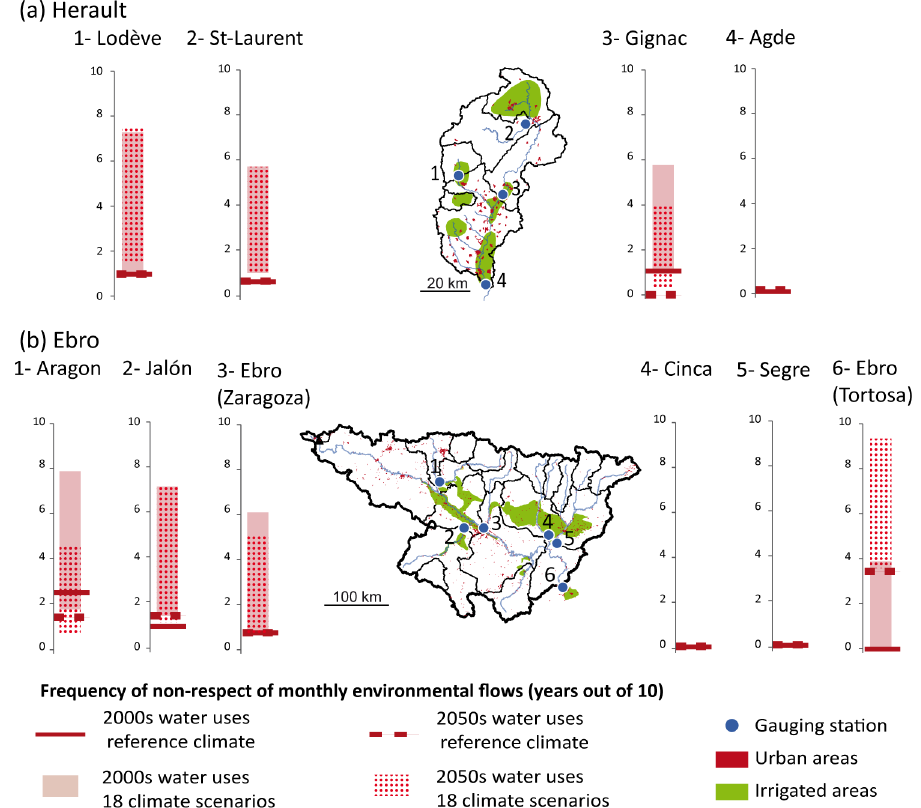
Figure 7. Frequency of years (out of 10) with monthly influenced streamflow inferior to the objective monthly environmental flow Q OBJ in (a) the Herault basin and (b) the Ebro basin. Frequencies are considered acceptable under 2 years out of